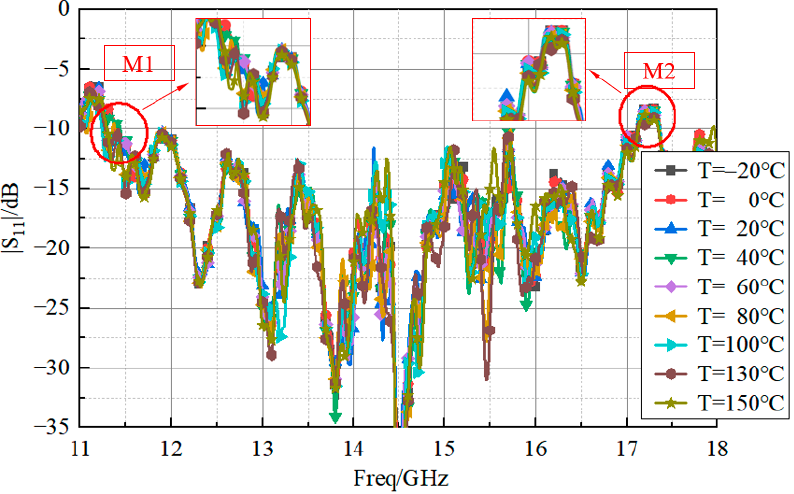
Figure 17. Measured re fl ection coe ffi cient at nine di ff erent temperatures.